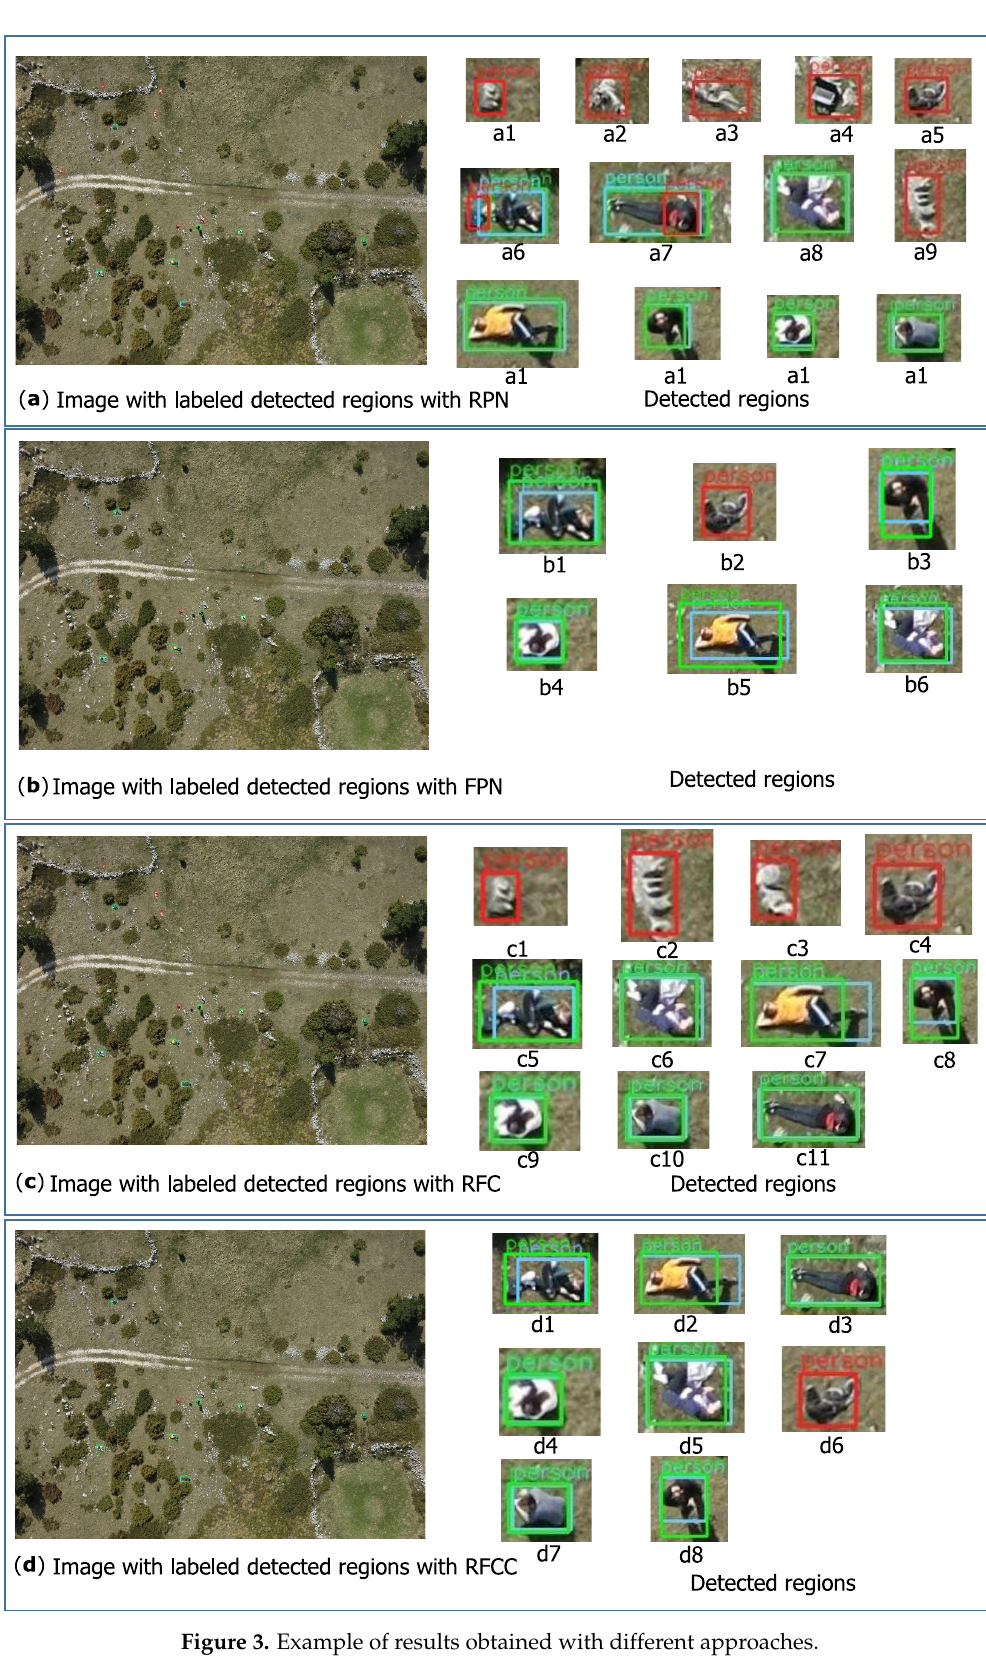
Figure 3. Example of results obtained with different